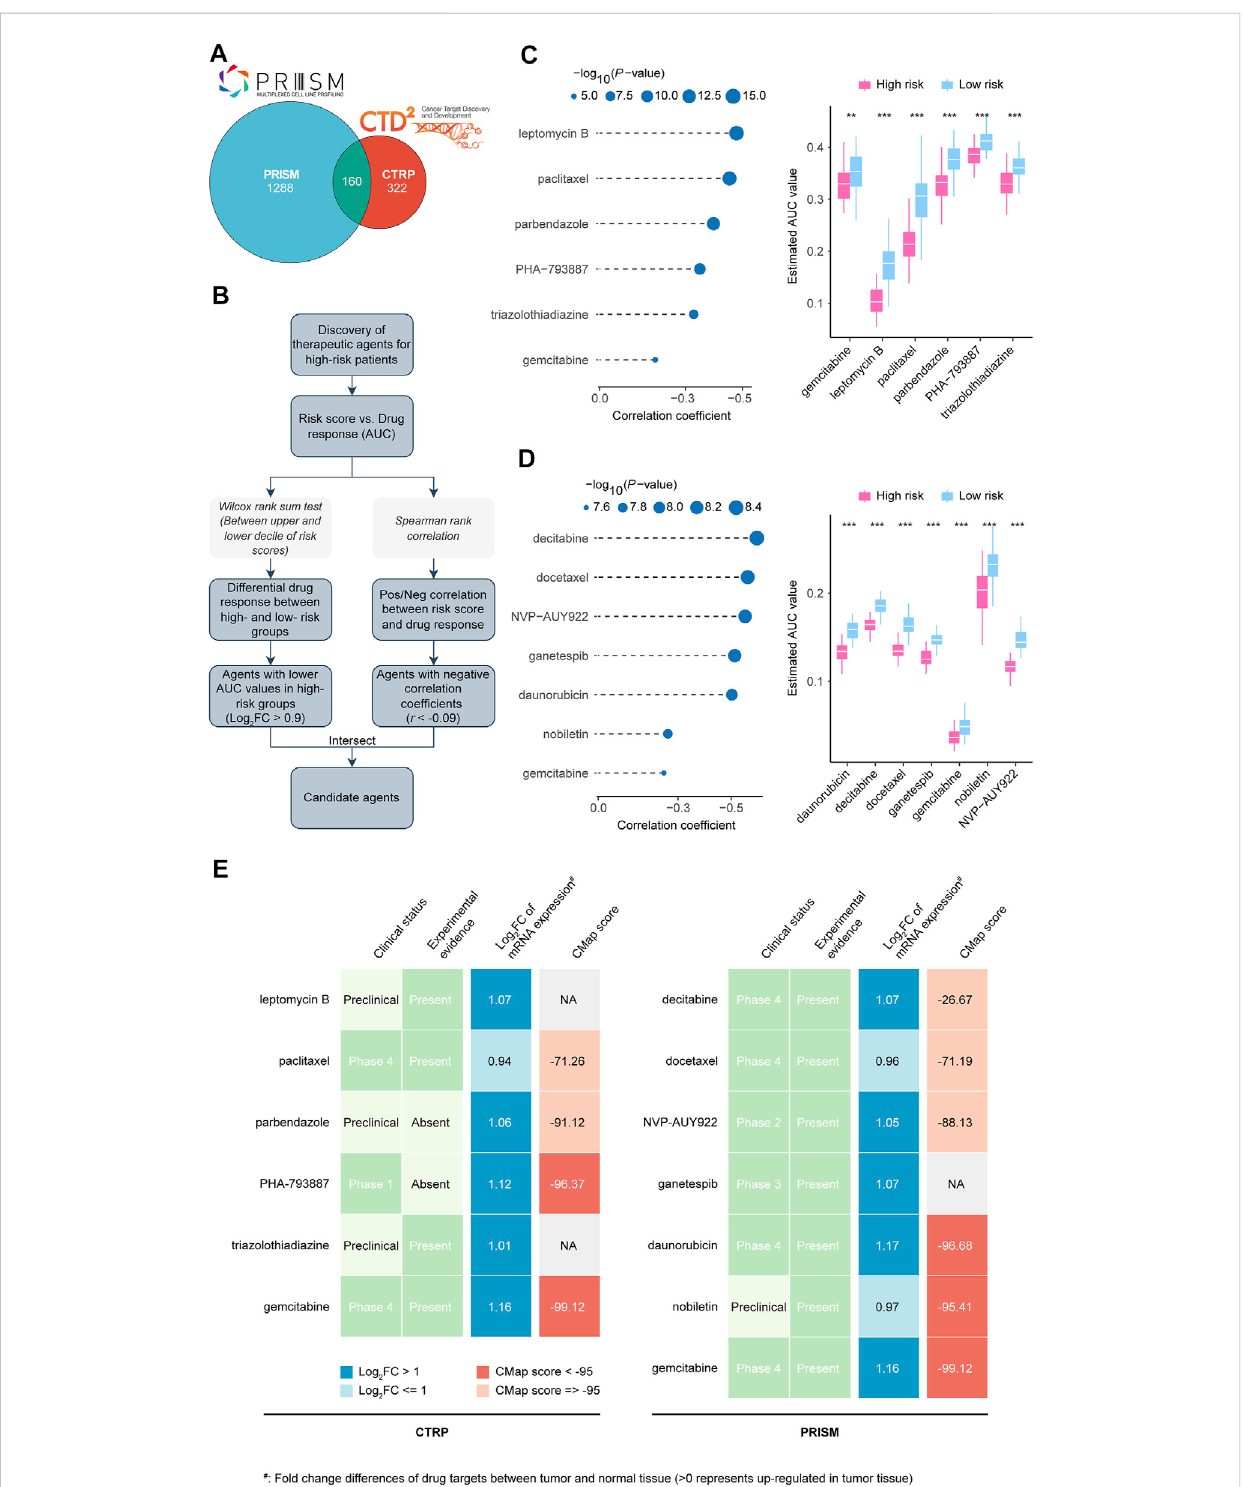
FIGURE 9 Identi fi cation of candidate agents with higher drug sensitivity in high CRLncSig risk score patients. (A) A venn diagram for summarizing included compounds from CTRP and PRISM datasets. (B) Schematic outlining the strategy to identify agents with higher drug sensitivity in high risk score patients. (C) The results of Spearman ’ s correlation analysis and differential drug response analysis of six CTRP-derived compounds. The lower the value of the y -axis, the greater the drug sensitivity. (D) The results of Spearman ’ s correlation analysis and differential drug response analysis of seven PRISM- derivedcompounds.Thelowerthevalueofthe y -axis,thegreaterthedrugsensitivity. (E) Identi fi cationofmostpromising therapeuticagentsforhighrisk score patients according to the evidence from multiple sources). Six CTRP-derived agents and seven PRISM-derived agents were shown on the left and right of the diagram, respectively. CRLncSig, cuproptosis-regulated lncRNA signature; Pos/Neg, Positively/Negatively; ** p- value < 0.01; *** p-value < 0.001; p-value < 0.05 was considered statistically signi fi